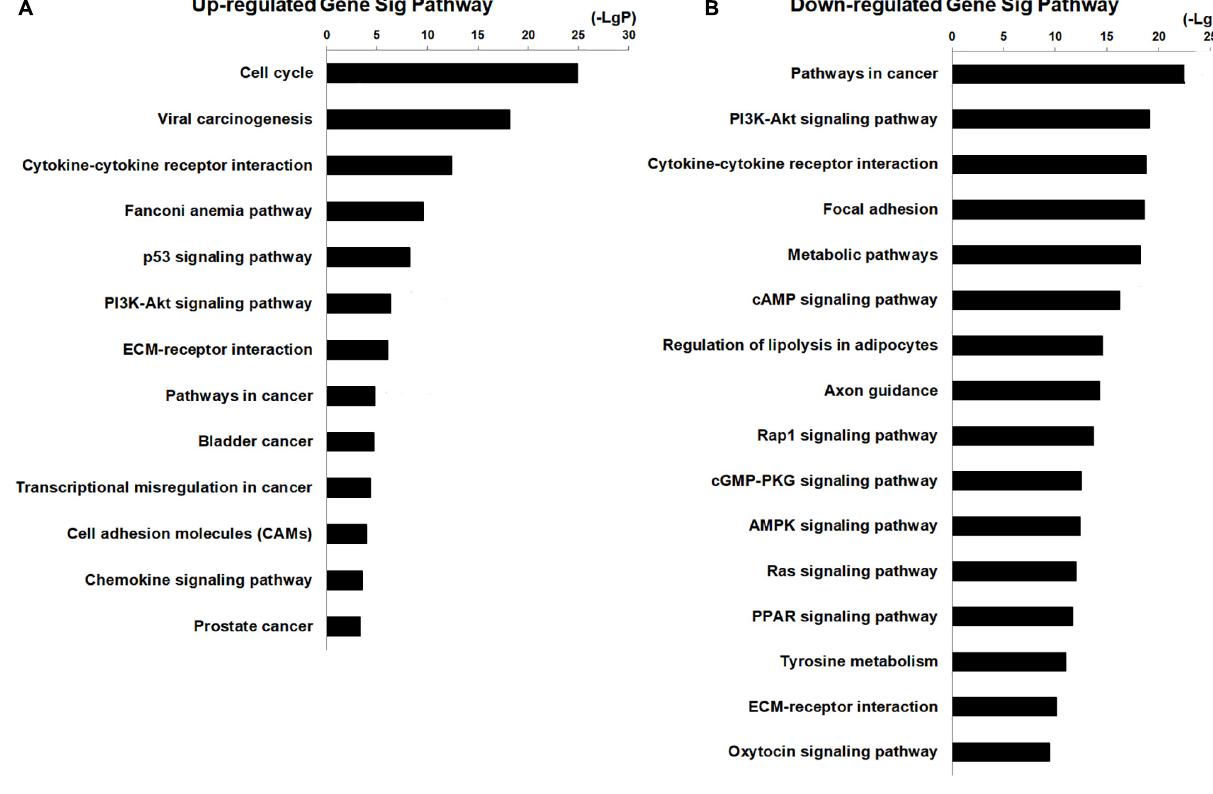
Frontiers in Genetics |